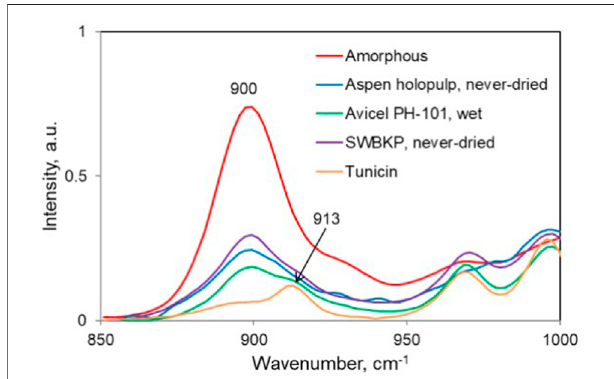
FIGURE 4 | 900-cm − 1 region of the normalized Raman spectra of selected samples listed in Table 3 . The crystalline contribution present at 913 cm − 1 can also be seen for some